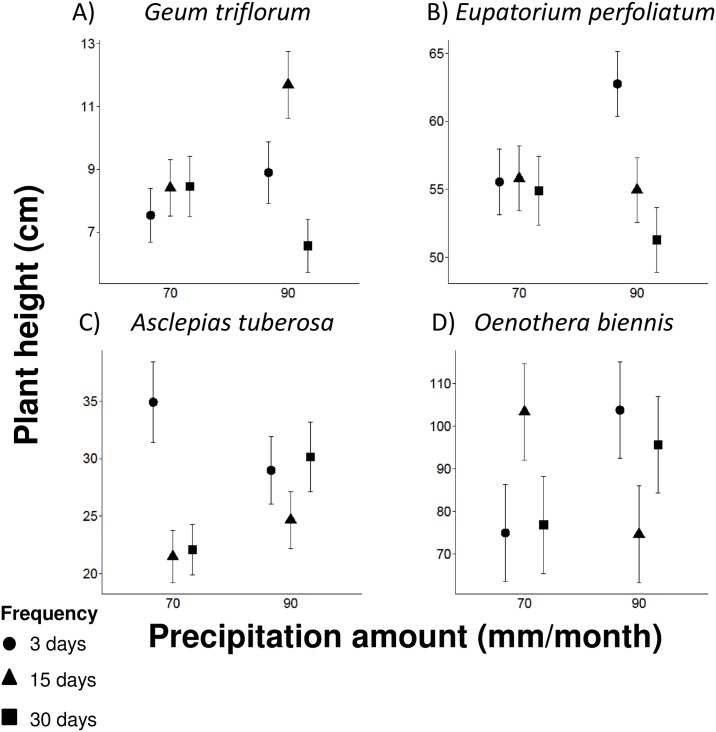
Plant height in response to precipitation amount and frequency.The effects of precipitation amount and frequency on plant height. Precipitation amount and frequency interacted to affect: (A) Geum triflorum, (B) Eupatorium perfoliatum, (C) Asclepias tuberosa, and (D) Oenothera biennis. The main effect of precipitation frequency also affected the species depicted in A-C, whereas the main effect of precipitation amount did not significantly affect any species. Points show least-squares mean values and whiskers denote ± 1 SE around the mean.